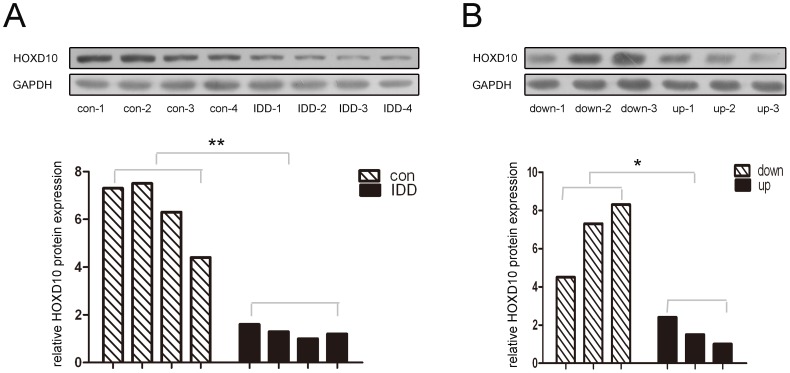
HOXD10 is down-expression in degenerative NP tissues.(A) The protein levels of HOXD10 were down-regulated in four degenerative NP tissues and the idiopathic scoliosis tissues. (B) Western blot analysis of HOXD10 protein expression in three patients whose miR-10b expression was down-regulated in NP tissues compared to the three patients whose miR-10b expression was up-regulated in NP tissues. As compared with control, **p<0.01 and *p<0.05.